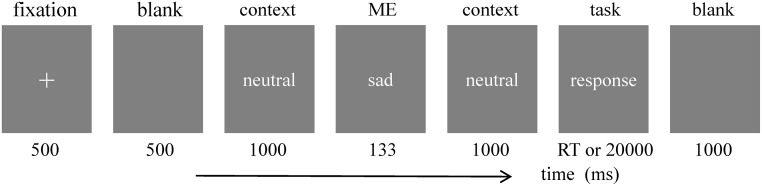
The flow chart of one trial.